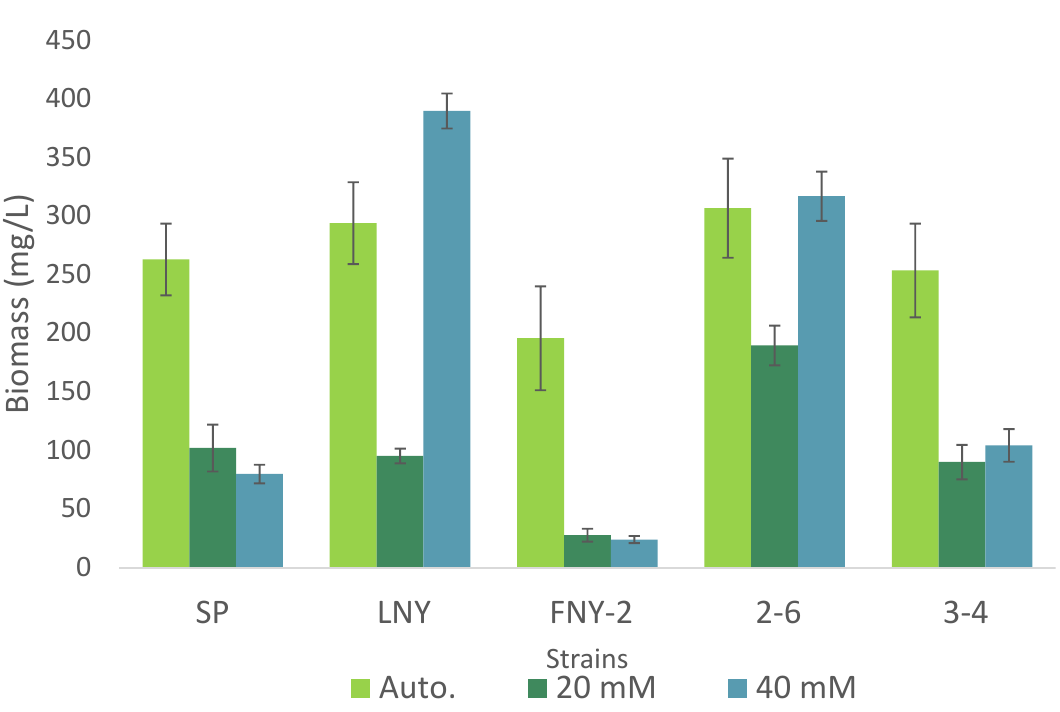
Figure 2. Comparison of biomass accumulation of algal strains grown under autotrophic conditions and heterotrophic conditions with 20 or 40 mM glycerol. Means ± SE, n = 3.